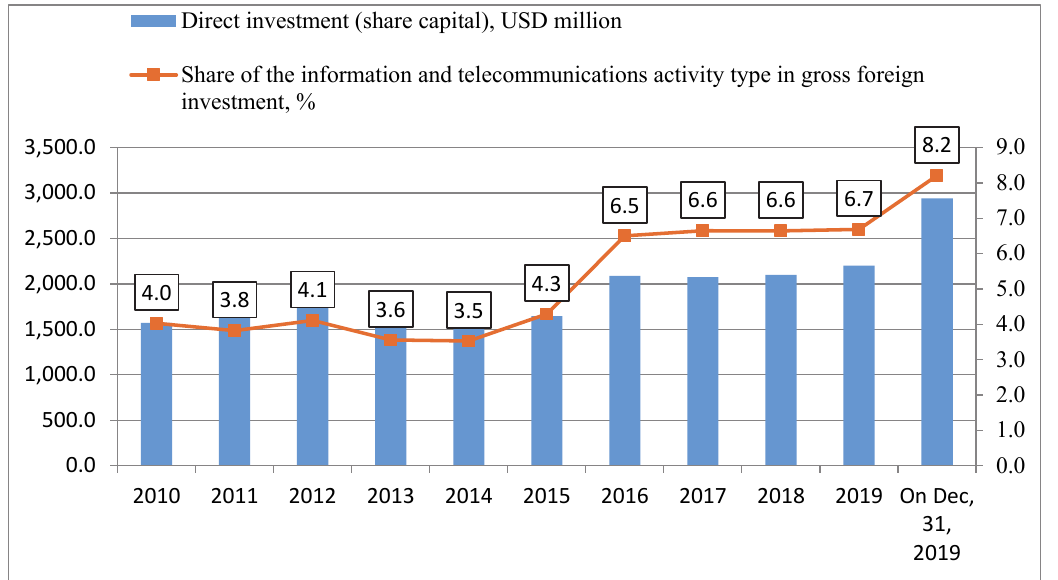
Fig. 3. Dynamics of foreign investment in the development of economic activity type “information and telecommunications” in